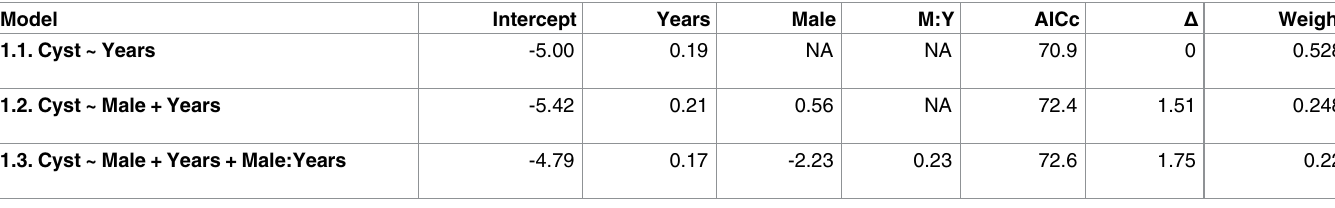
and weights of each model are